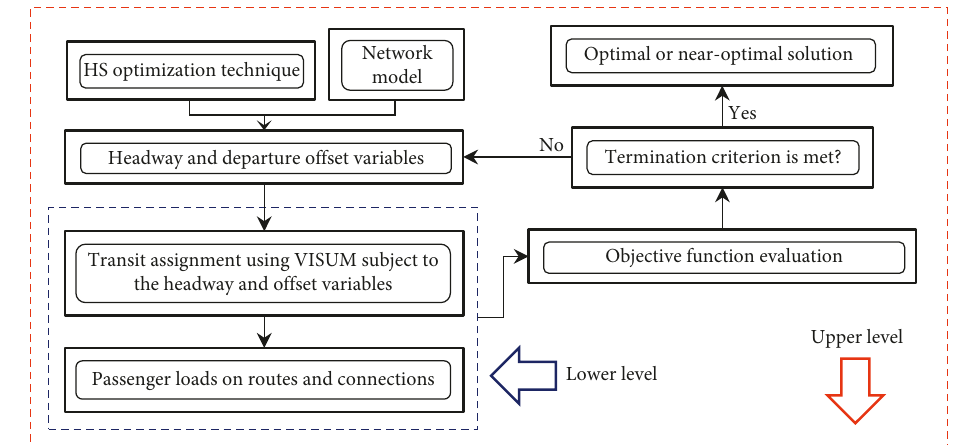
Figure 2: Layout of the proposed bilevel model.